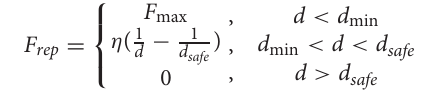
free path is to search for the descending direction of the potential